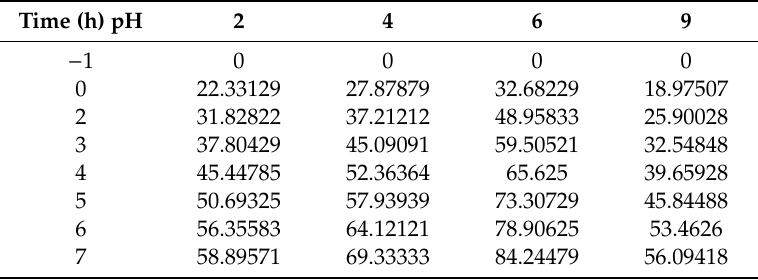
Table 5. Removal rate of MB at di ff erent pH.